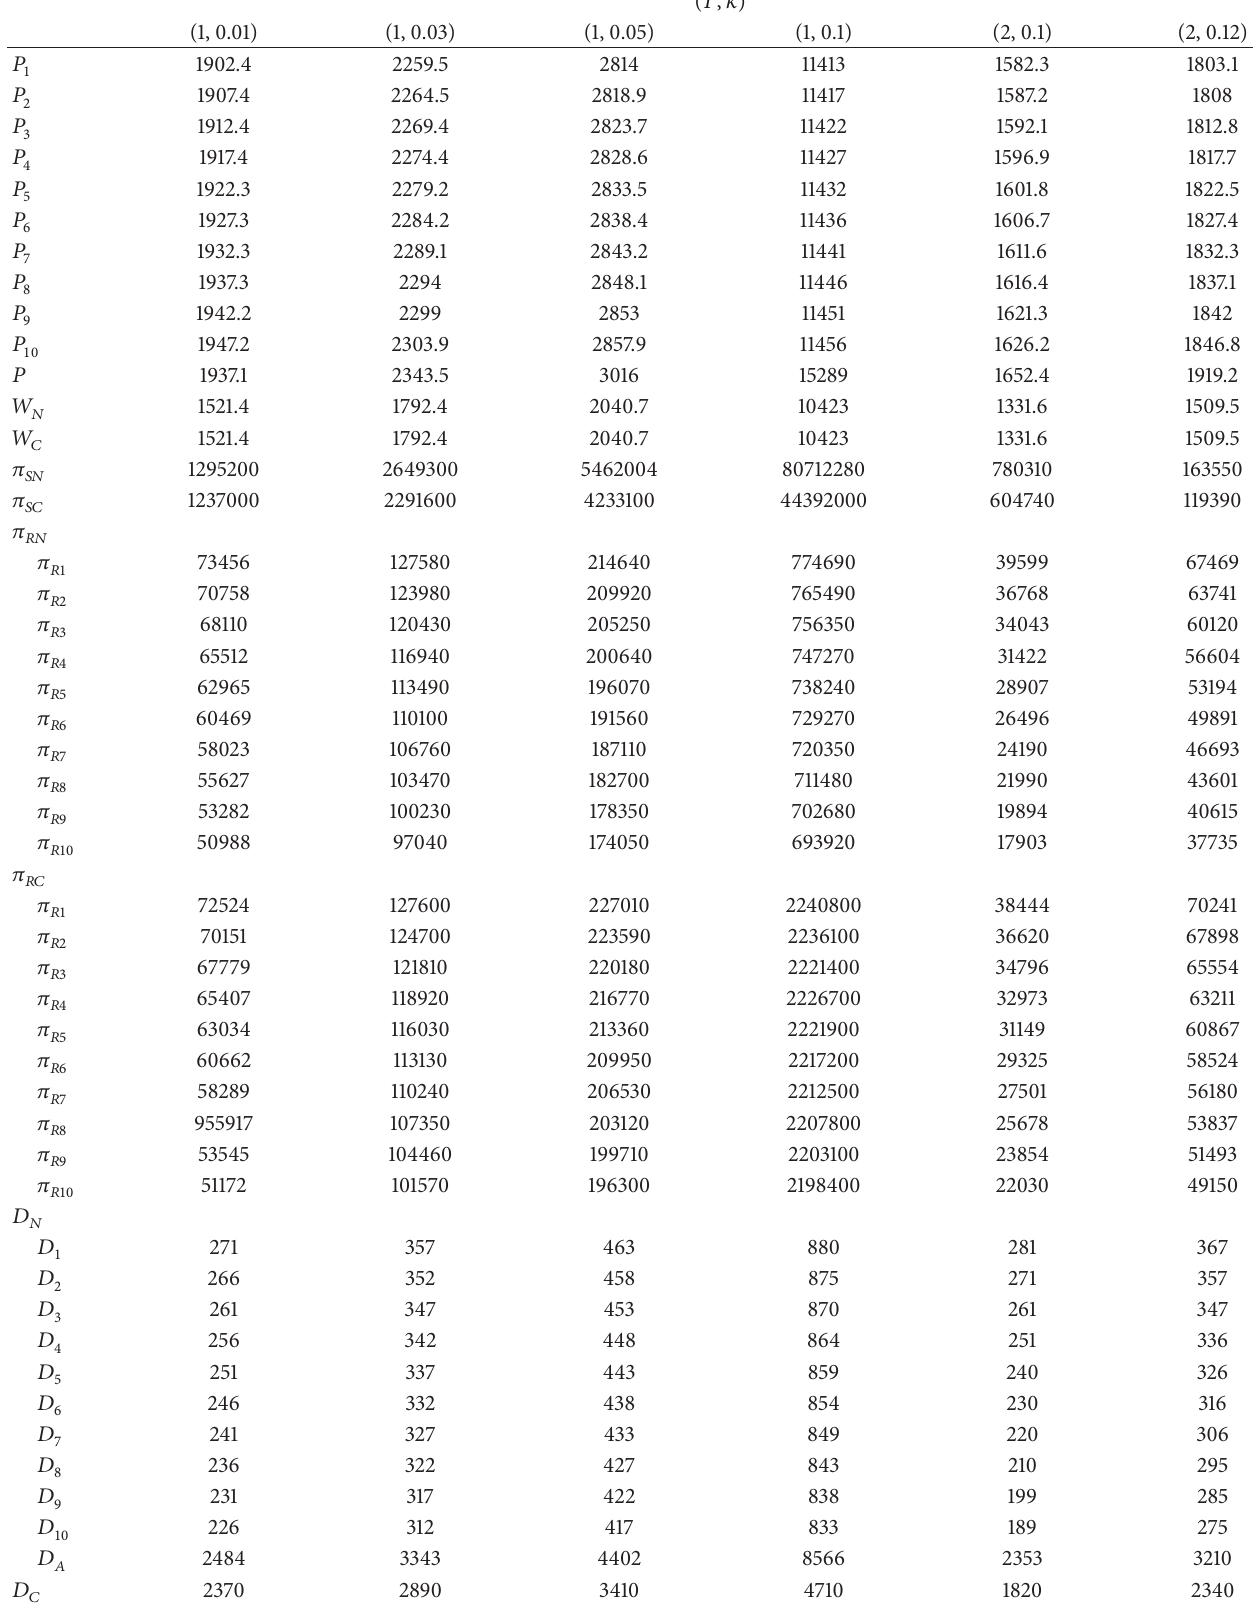
Table 1: The variety of decision variables and profits influenced by 𝑇 , 𝑘